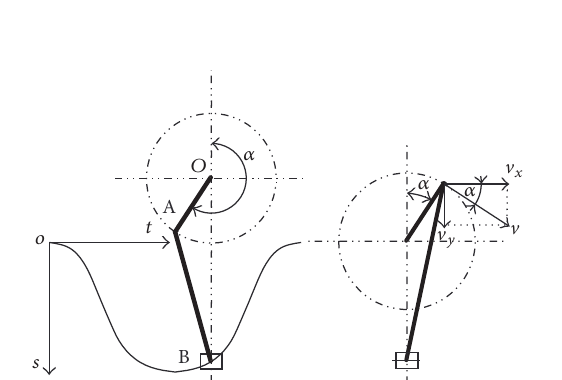
Figure 7: Blank layout for the heat exchanger fin.